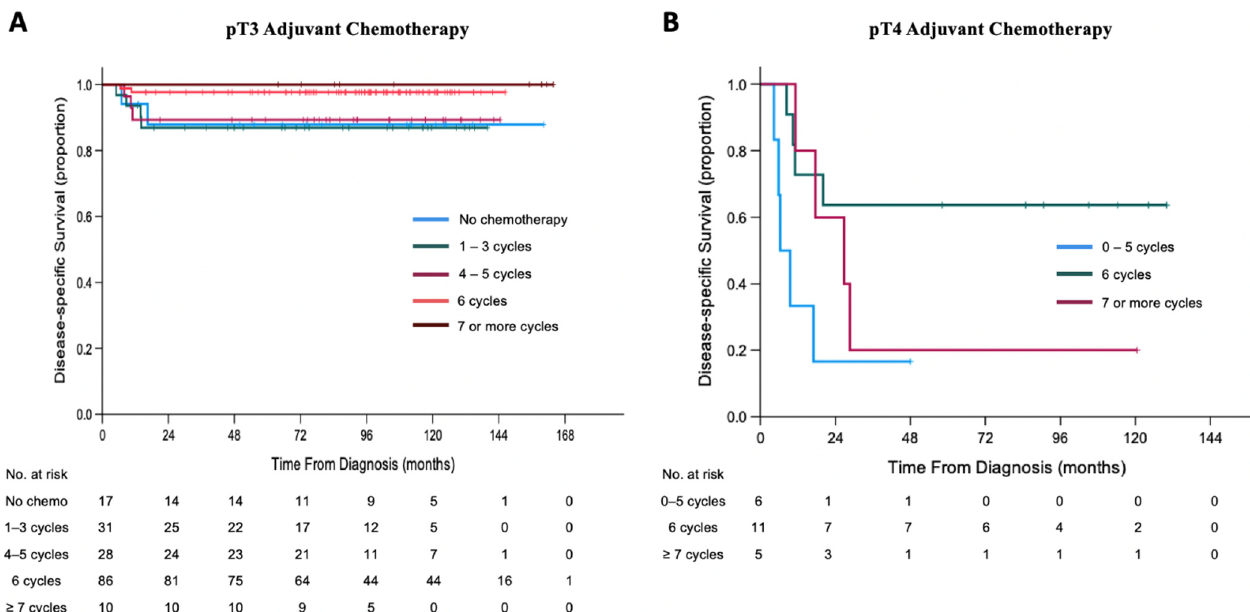
Figure 3. Kaplan–Meier curves of disease-specific survival (DSS) of patients treated with different cycles of adjuvant chemotherapy for AJCC 8th edition. ( A ) pT3 pathology. ( B ) pT4 pathology.